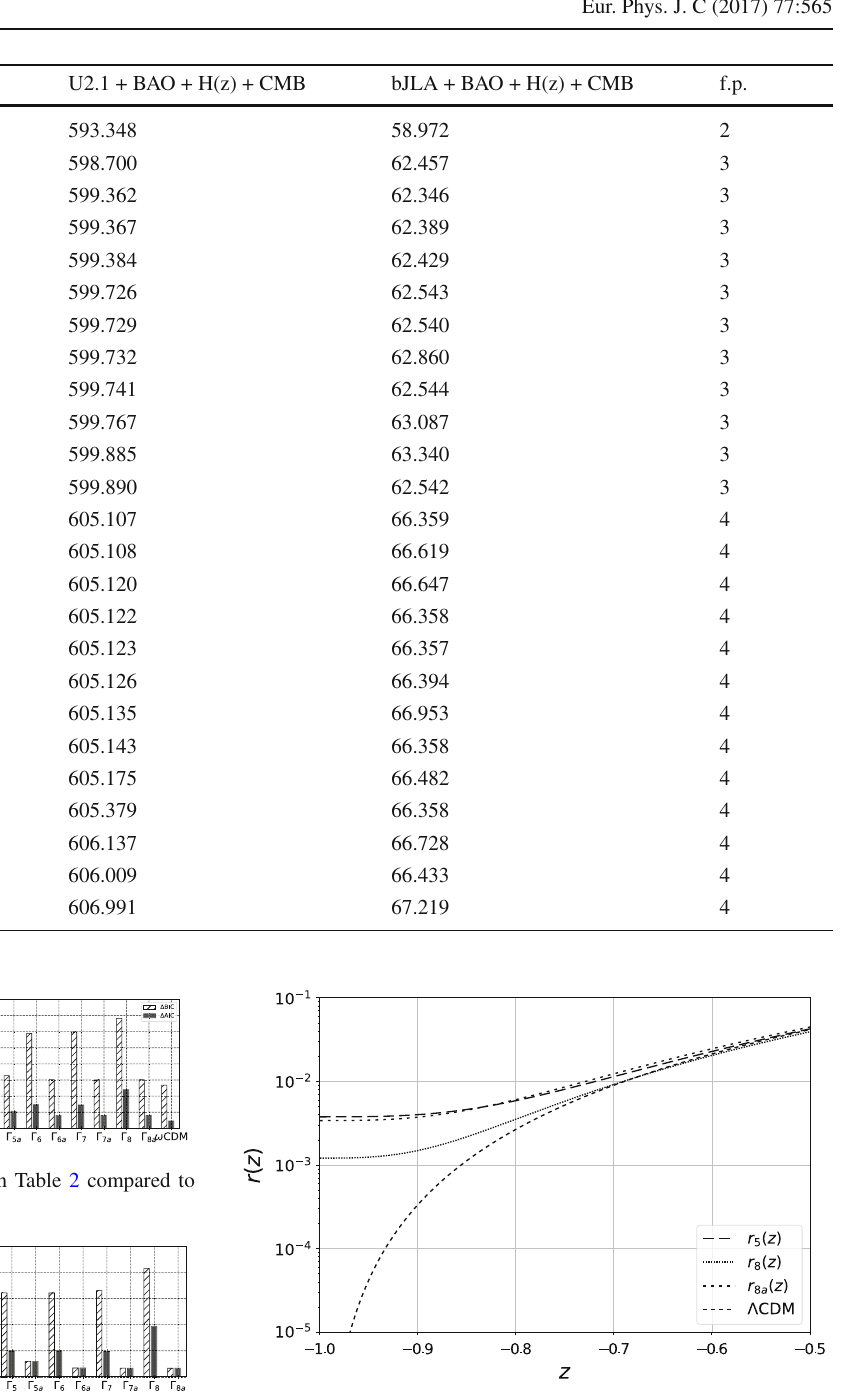
Fig. 2 (cid:9) AIC and (cid:9) BIC of interacting models defined in Table 2 com- pared to the ω CDM model